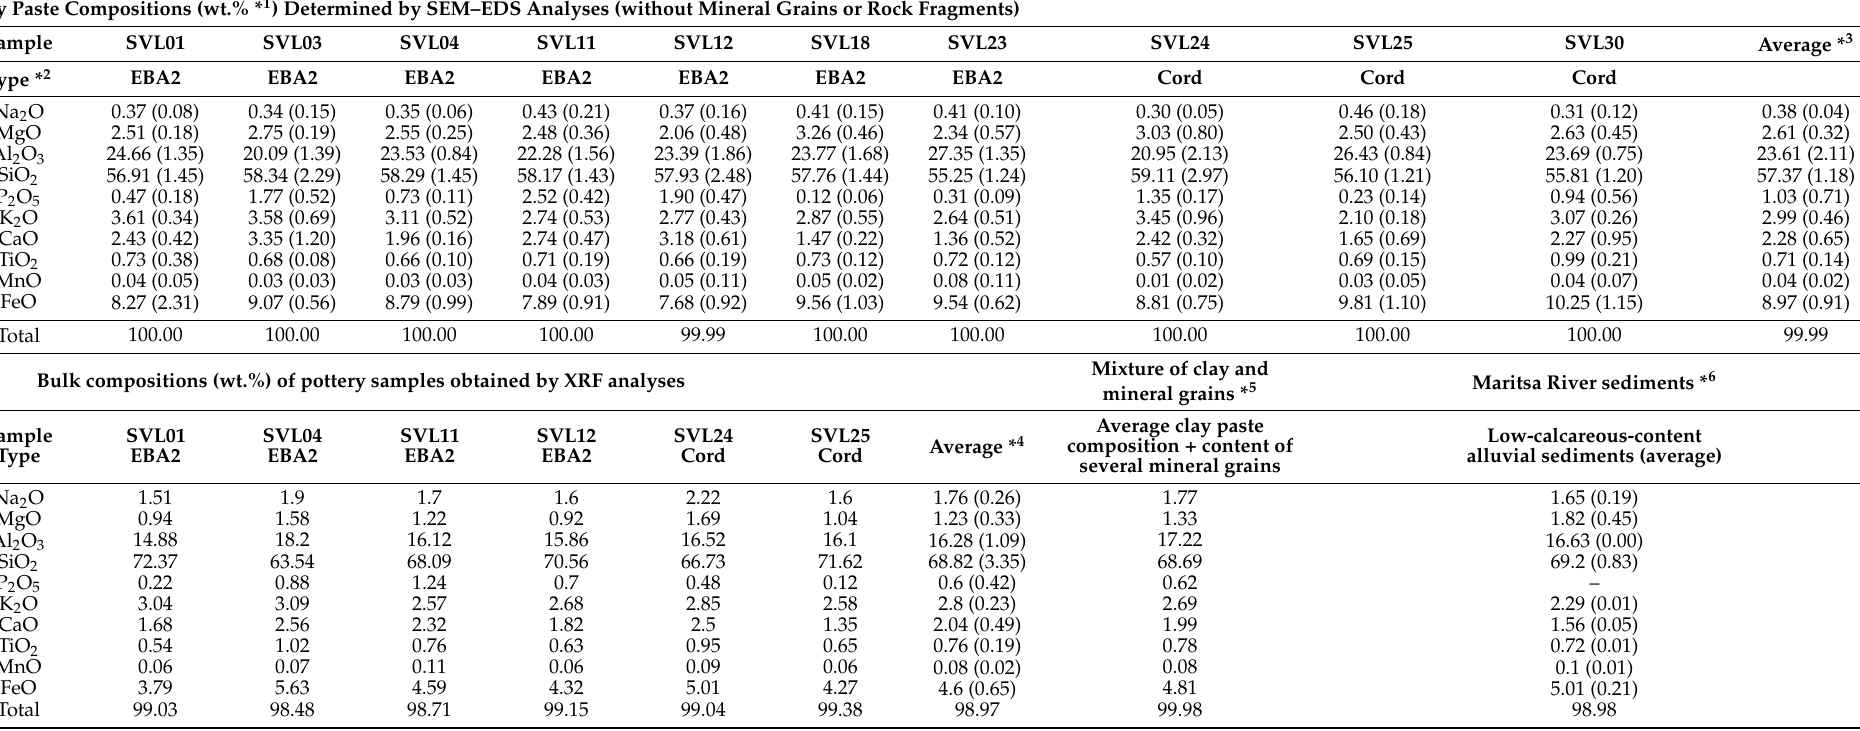
Table 4. Chemical compositions of clay pastes in pottery samples, bulk pottery samples, mixtures of clay paste and mineral grains, and Maritsa River sediments. * 1 Average value of the five-point analyses; standard deviations in parentheses. * 2 Pottery type: EBA2—local-made type; Cord—pottery with cord decoration. * 3 Average values for the results of 10 pottery samples; standard deviations in parentheses. * 4 Average values for the results of six pottery samples and standard deviations. * 5 Mixture composition estimated from the average clay paste composition and the chemical compositions of the mineral grains (Table 1). The mixing ratios were 47.6 vol.% clay paste, 25.7 vol.% quartz, 16.4 vol.% plagioclase, 5.0 vol.% potassium feldspar, 4.2 vol.% muscovite, 0.8 vol.% ilmenite, and 0.3 vol.% apatite. * 6 Average composition excluding water content of low-calcareous-content alluvial (flood-plain) sediments near the Maritsa River [42]; standard deviations in parentheses. –, Not